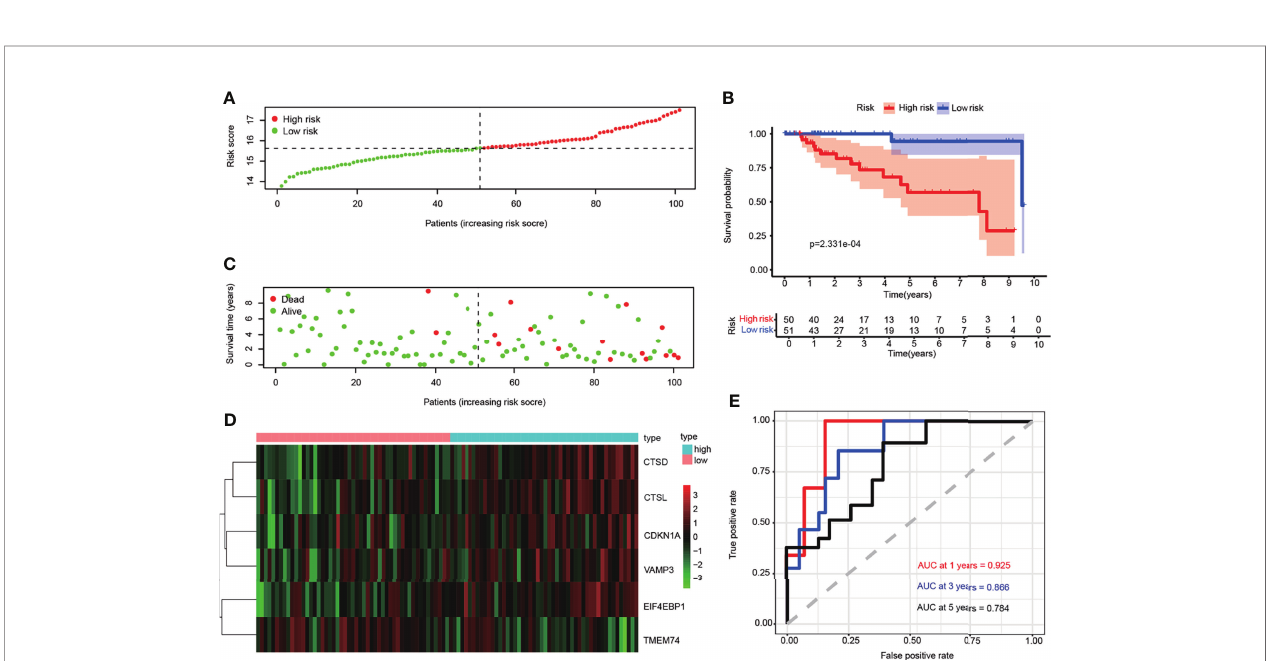
FIGURE 4 | Correlation between the risk score and overall survival in the train set. (A) The risk score strati fi ed the TNBC patients into high-risk groups ( “ High ” red line) and low-risk groups ( “ Low ” green line). (B) Kaplan – Meier survival curves to show survival probability comparing the high-risk groups with low-risk group. (C) Comparison of survival time and survival status of patients in TNBC between high- and low-risk groups. Green plots for alive, red plots for dead. (D) Heatmap showing expression of the six genes screened from ARGs in TNBC. Blue color represents high-risk group, while pink color represents low-risk group. The color scale represented the expression levels normalized by z-score. (E) Time-dependent ROC curves for survival prediction by the risk